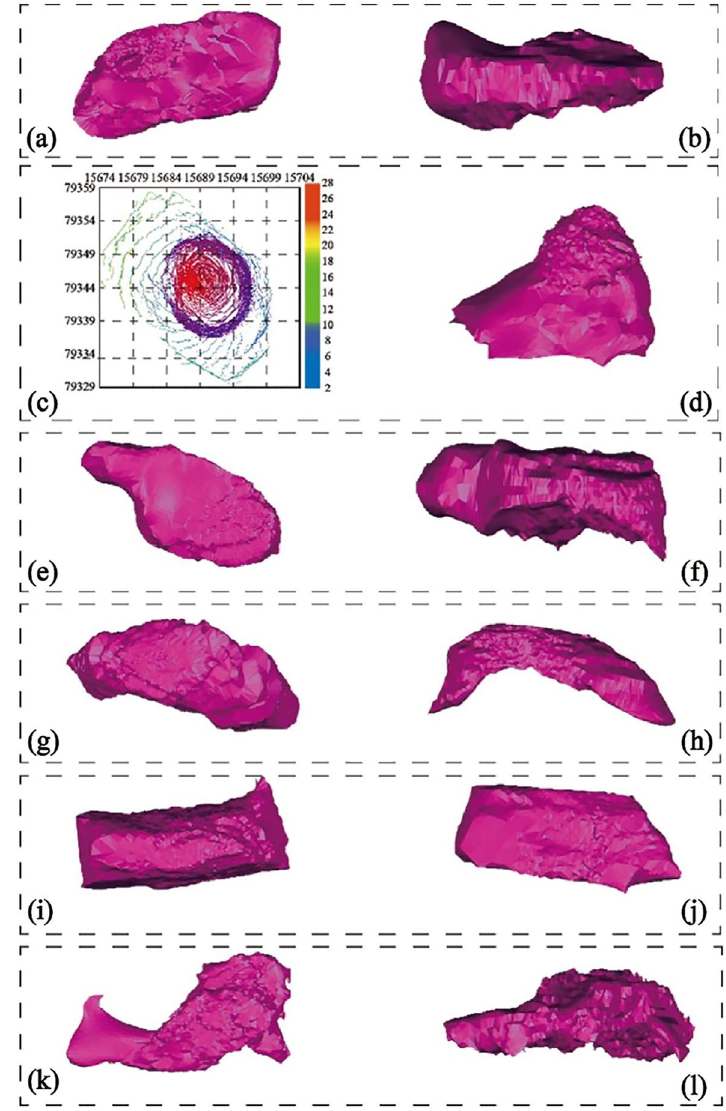
Figure 10. Representative goaf in goaf group: ( a ) Three-dimensional model of short axis of cavity in borehole 1275-122; ( b ) Three-dimensional model of long axis of cavity in borehole 1275-122; ( c ) Three-dimensional model of major axis of the goaf exposed by the 1320 flat A-59 borehole; ( d ) Three-dimensional model of minor axis of the goaf exposed by the 1320 flat A-59 borehole; ( e ) Three-dimensional model of short axis of borehole 1290-302; ( f ) Three-dimensional model of long axis of borehole 1290-302; ( g ) Three-dimensional model of short axis of goaf exposed by 1290 Pingpan 1290-303 borehole; ( h ) Three-dimensional model of long axis of goaf exposed by 1290 Pingpan 1290-303 borehole; ( i ) Three-dimensional model of major axis of borehole 1275-156 goaf; ( j ) Three-dimensional model of minor axis of borehole 1275-156 goaf; ( k ) Three-dimensional model of short axis of holes 1320-183, 1320-181 and 1320-182; ( l ) Three-dimensional model of long axis of holes 1320- 183, 1320-181 and